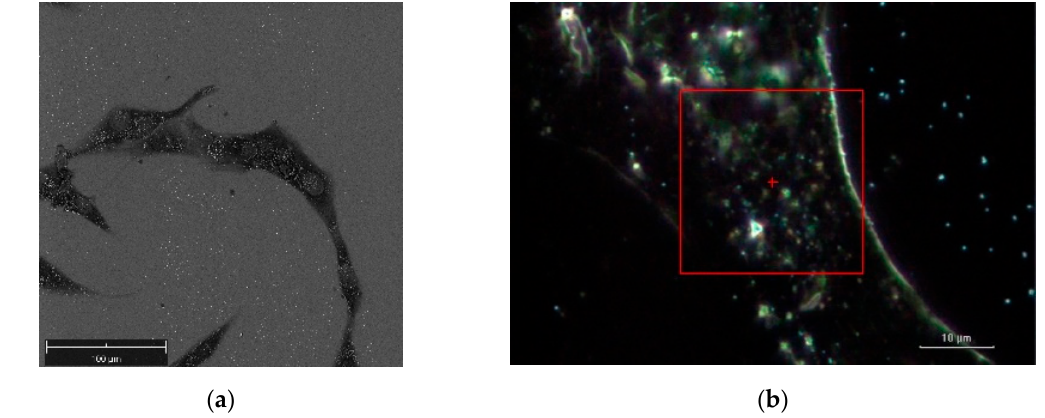
Figure 5. ( a ) SEM image of a cluster of MG-63 cells, the bright dots denote the AuNSs, scale bar 100 μ m. ( b ) Dark-field illumination at 100 × magnification on the DXR Raman microscope of a MG-63 cell crowded by gold nanoshells (AuNSs). The area under investigation is denoted by the red borders, scale bar 10 μ m.